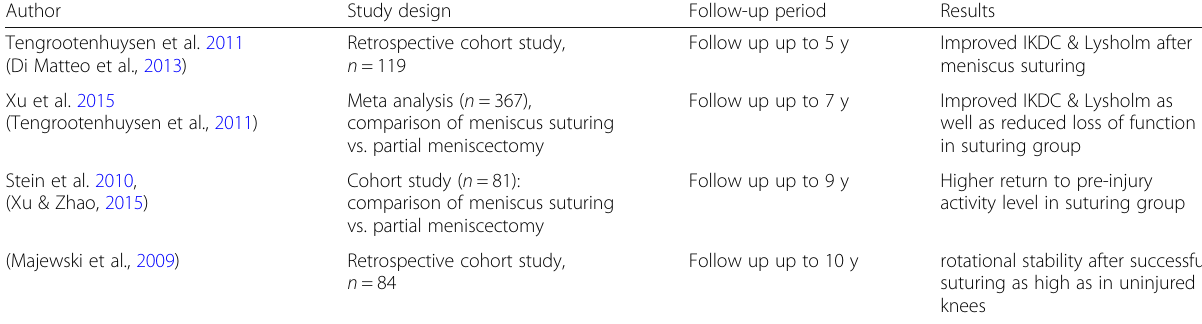
Table 1 Overview of performed studies conferning long-term outcome after meniscus suturing